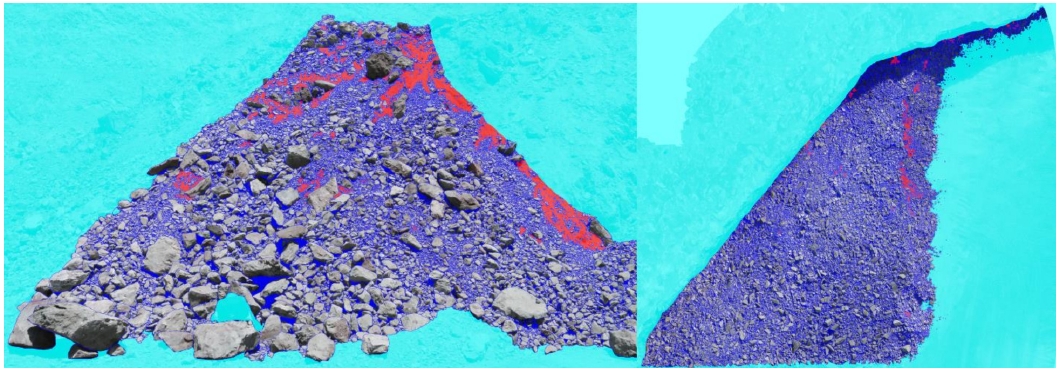
Figure 9. Images from Mine A ( left ) and Mine B ( right ) produced for image analysis of the blasted muck piles.